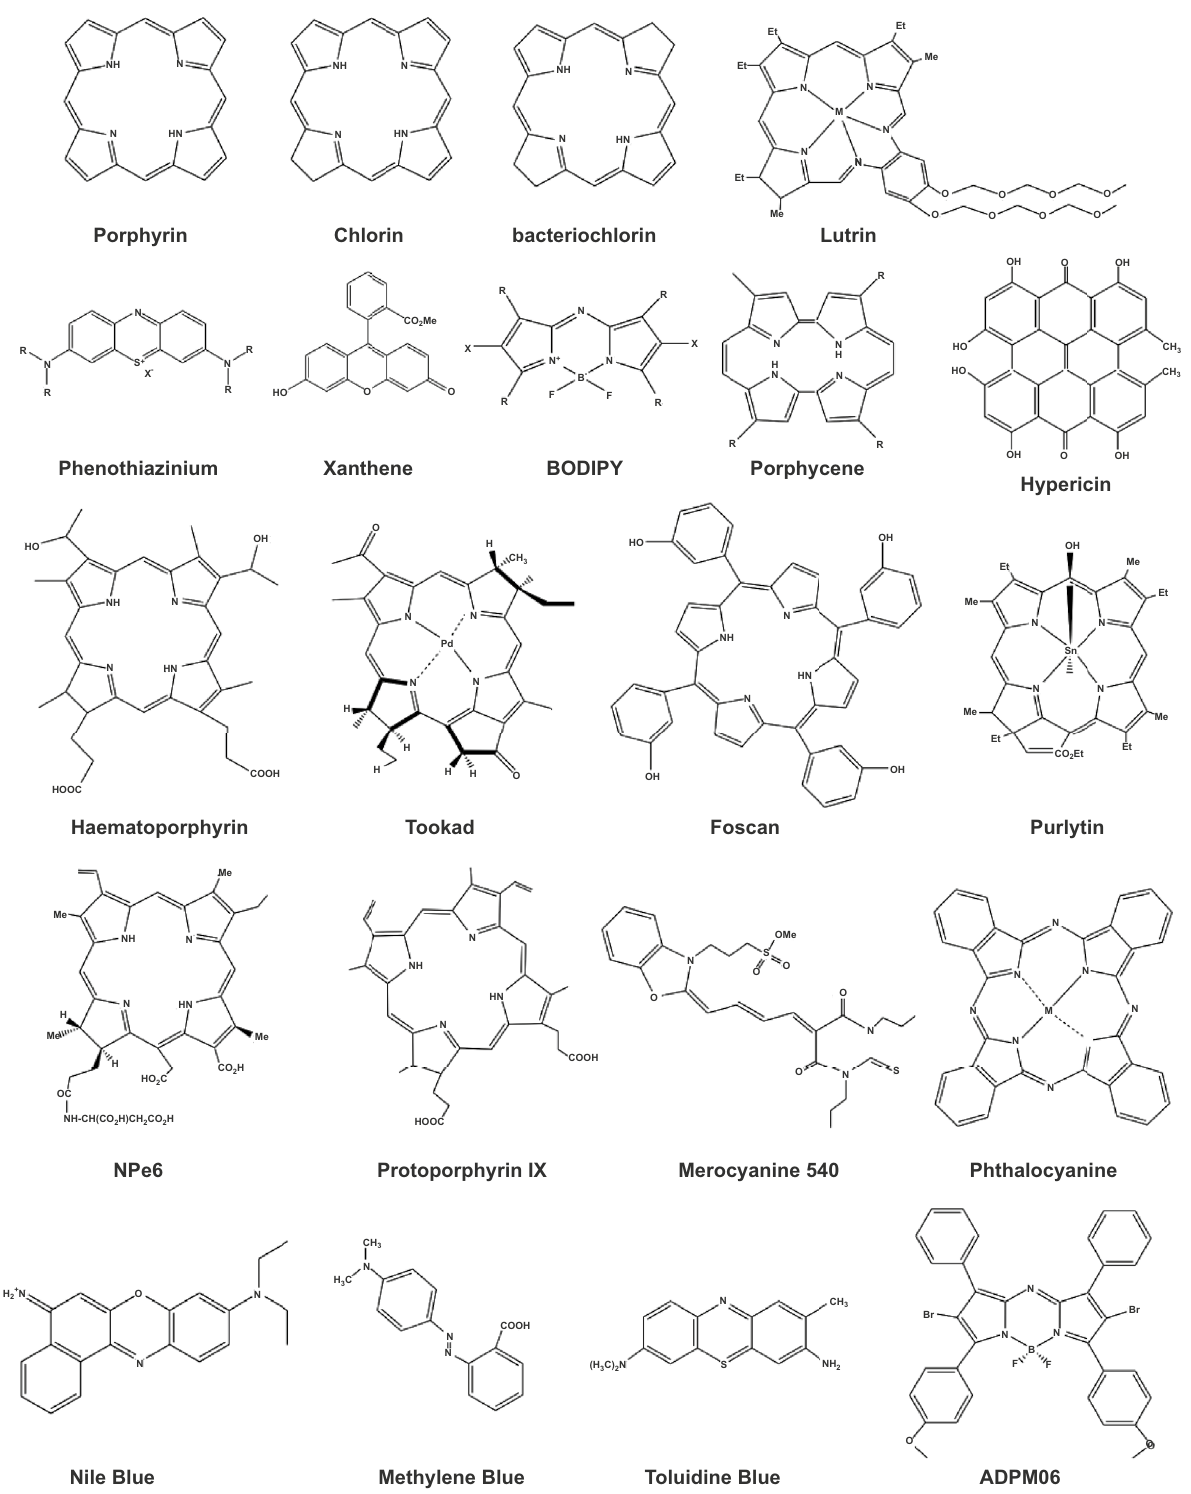
Fig. 3 The chemical skeleton of some classical